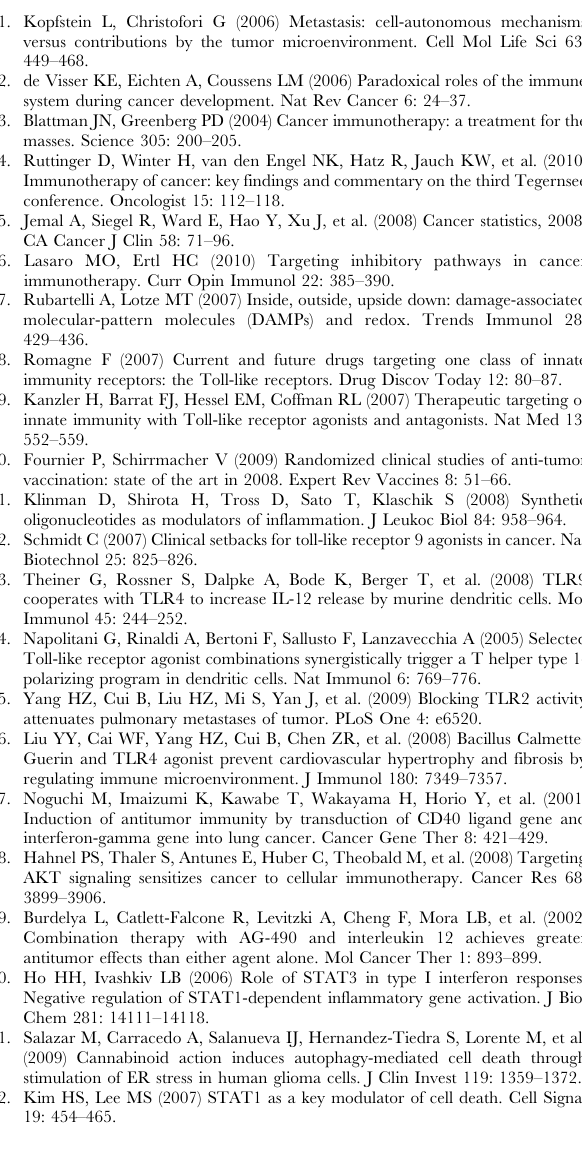
legend of Figure 1 and sacrificed on the 14th day after B16 melanoma cell inoculation. Lung tissue extracts were prepared as described in the Methods. The expression of p-STAT1, STAT1, p-STAT3, STAT3 and histone H3 in the nucleus and SOCS1, SOCS3 and b -actin in the cytoplasm were detected by western blot. The left panel represents immune blots, and the right panel is the related statistical results. Data are mean 6 S.E. (n=